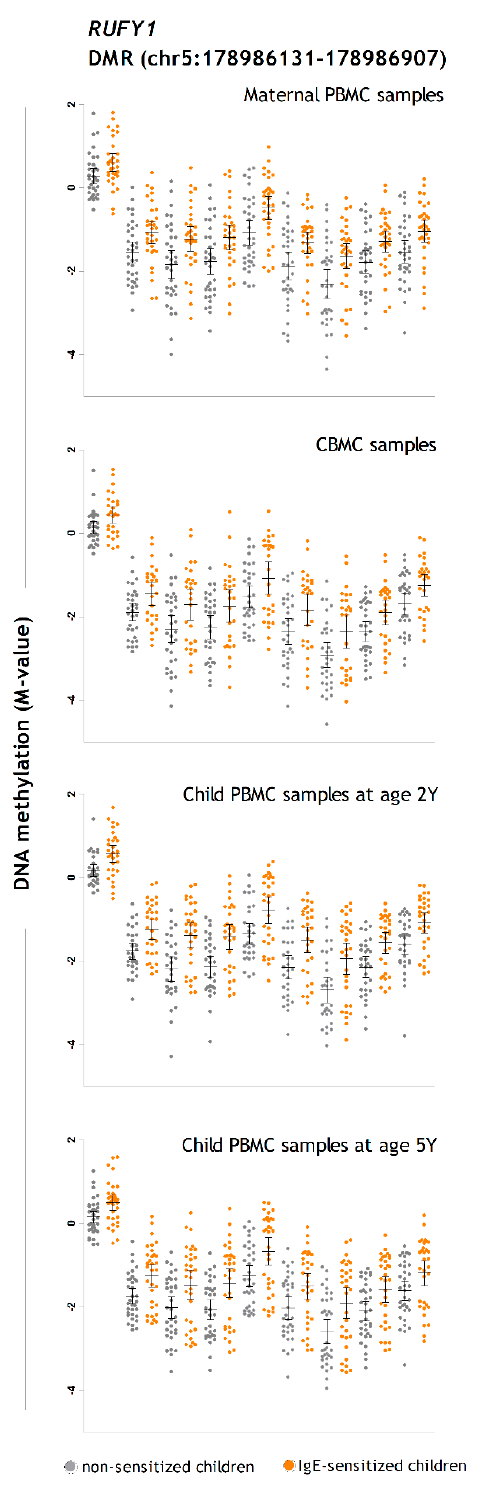
Figure 6. DNA methylation levels in nine CpG sites located in the DMR in RUFY1 gene per time point. From left to right: cg19626725, cg00080972, cg21226059, cg14820908 (located in the upstream shore) and cg02136620, cg09060608, cg05457628, cg22764044, and cg26516362 (in the CpG island). Detailed information on the genomic annotation of these CpG sites is presented in Spreadsheet File S2. Error bars represent mean and 95% confidence interval. Chr: chromosome.